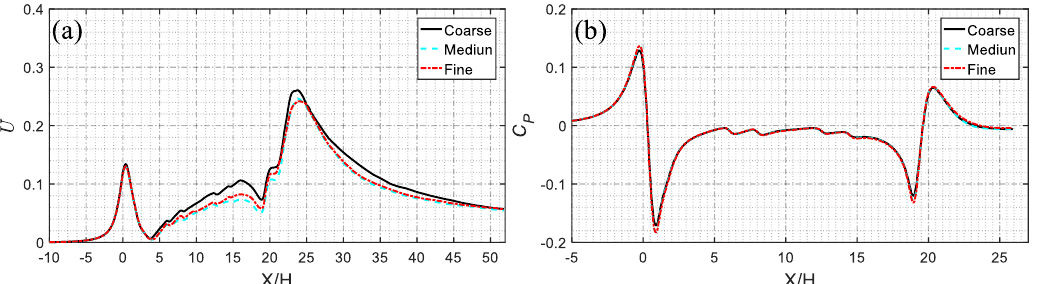
Figure 5. y+: ( a ) top view, ( b ) side view, and ( c ) bottom view.